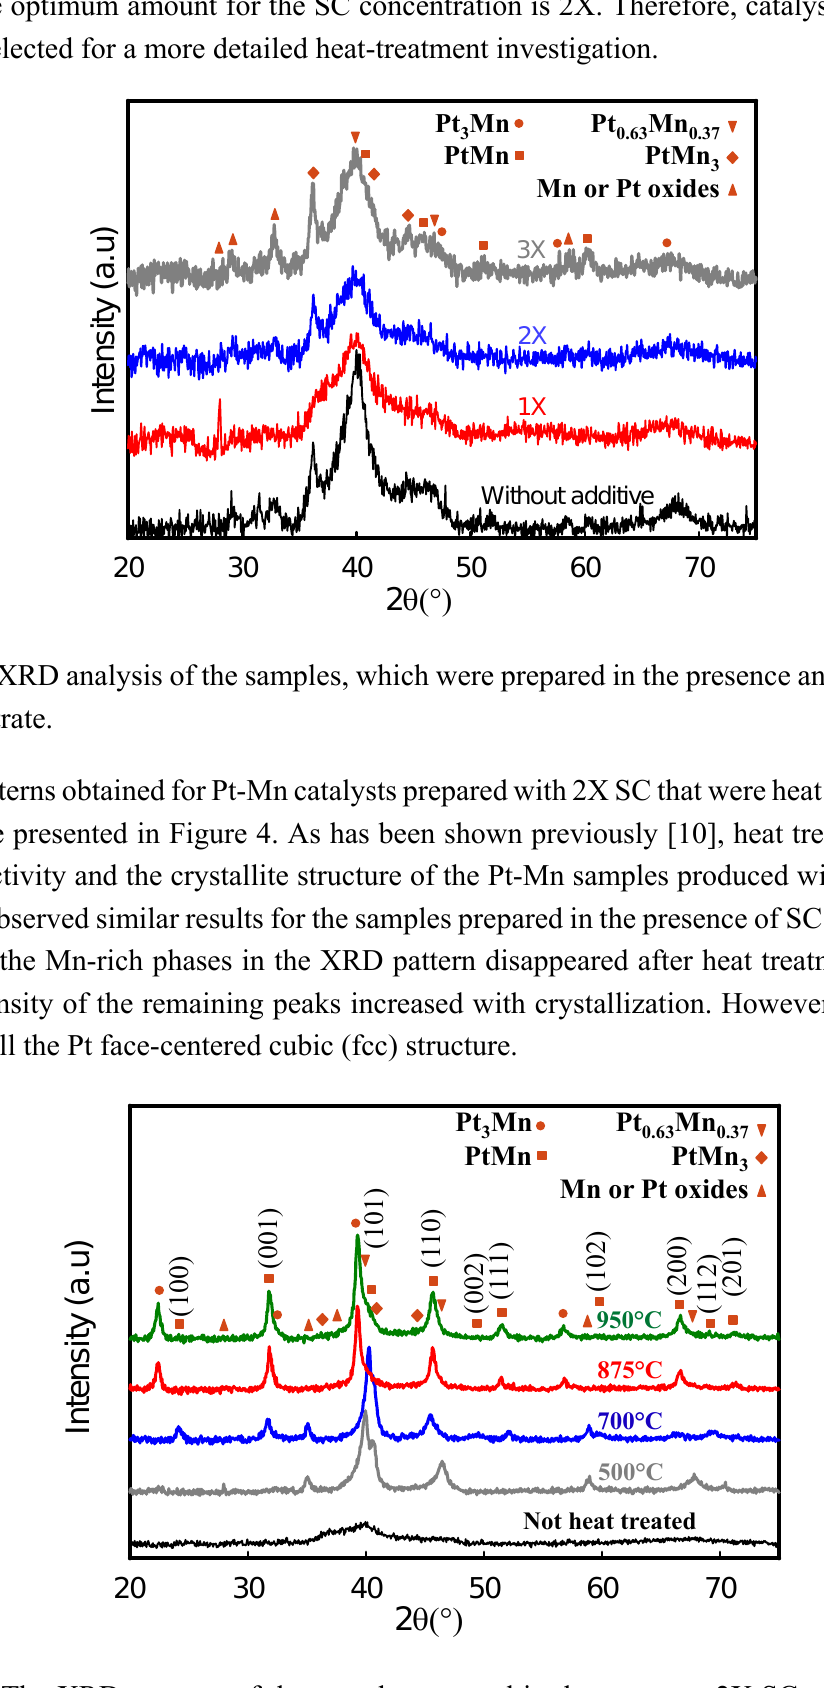
Figure 4. The XRD patterns of the sample prepared in the presence 2X SC and after heat treatment at different